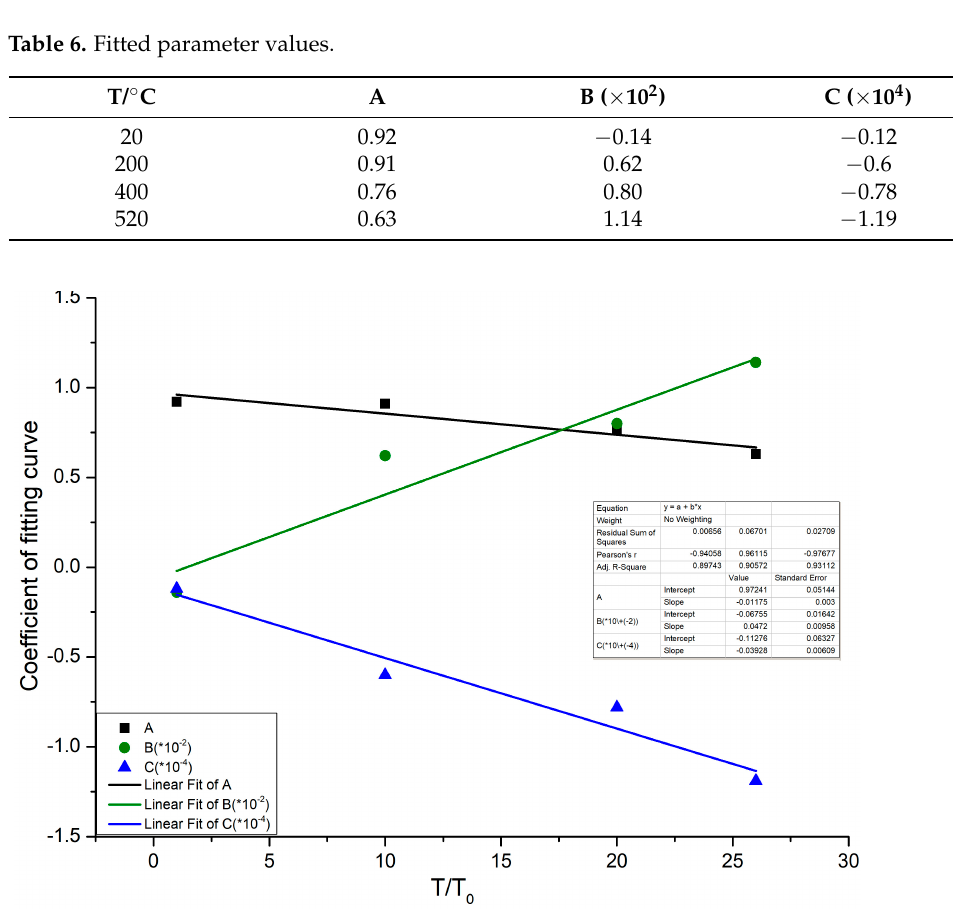
Figure 10. The variation trend of fitting coefficient with